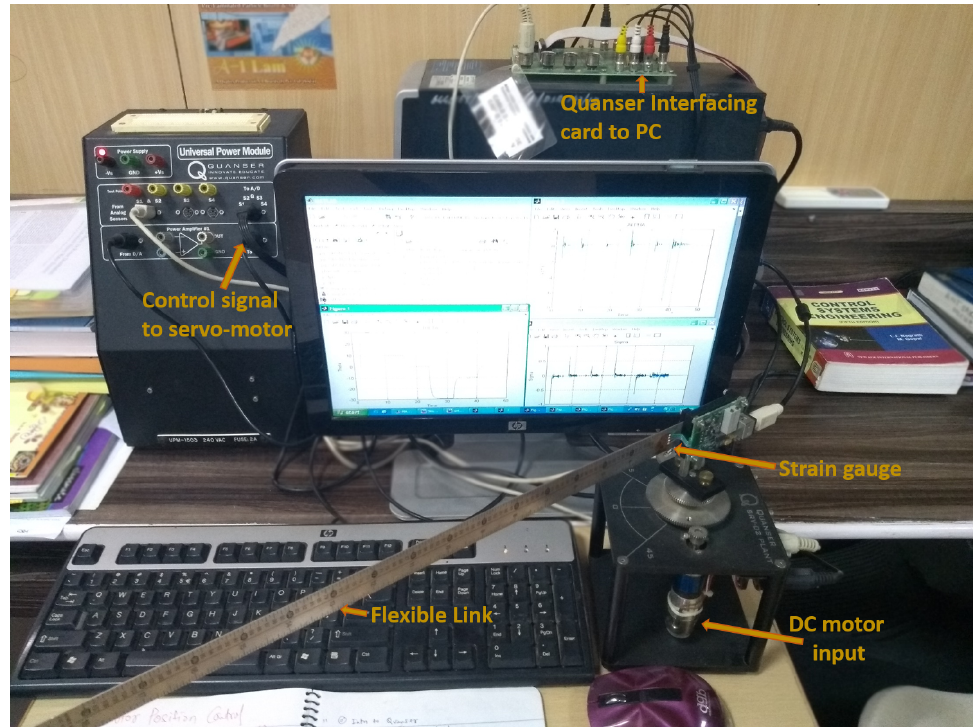
Figure 9. Flexible link experimental